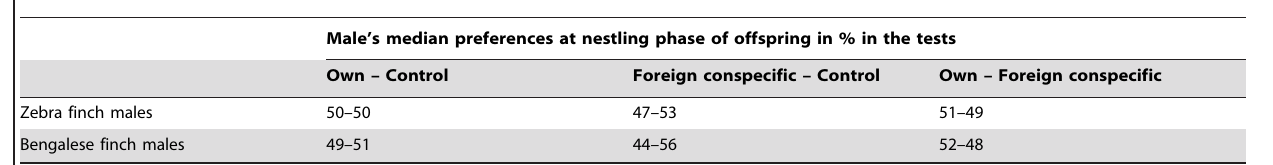
Table 1. Results of the odour preference tests of adult breeding males, at the experiments with nestling offspring in the nest, from both species the zebra finch and the Bengalese finch with nestlings in the nest.